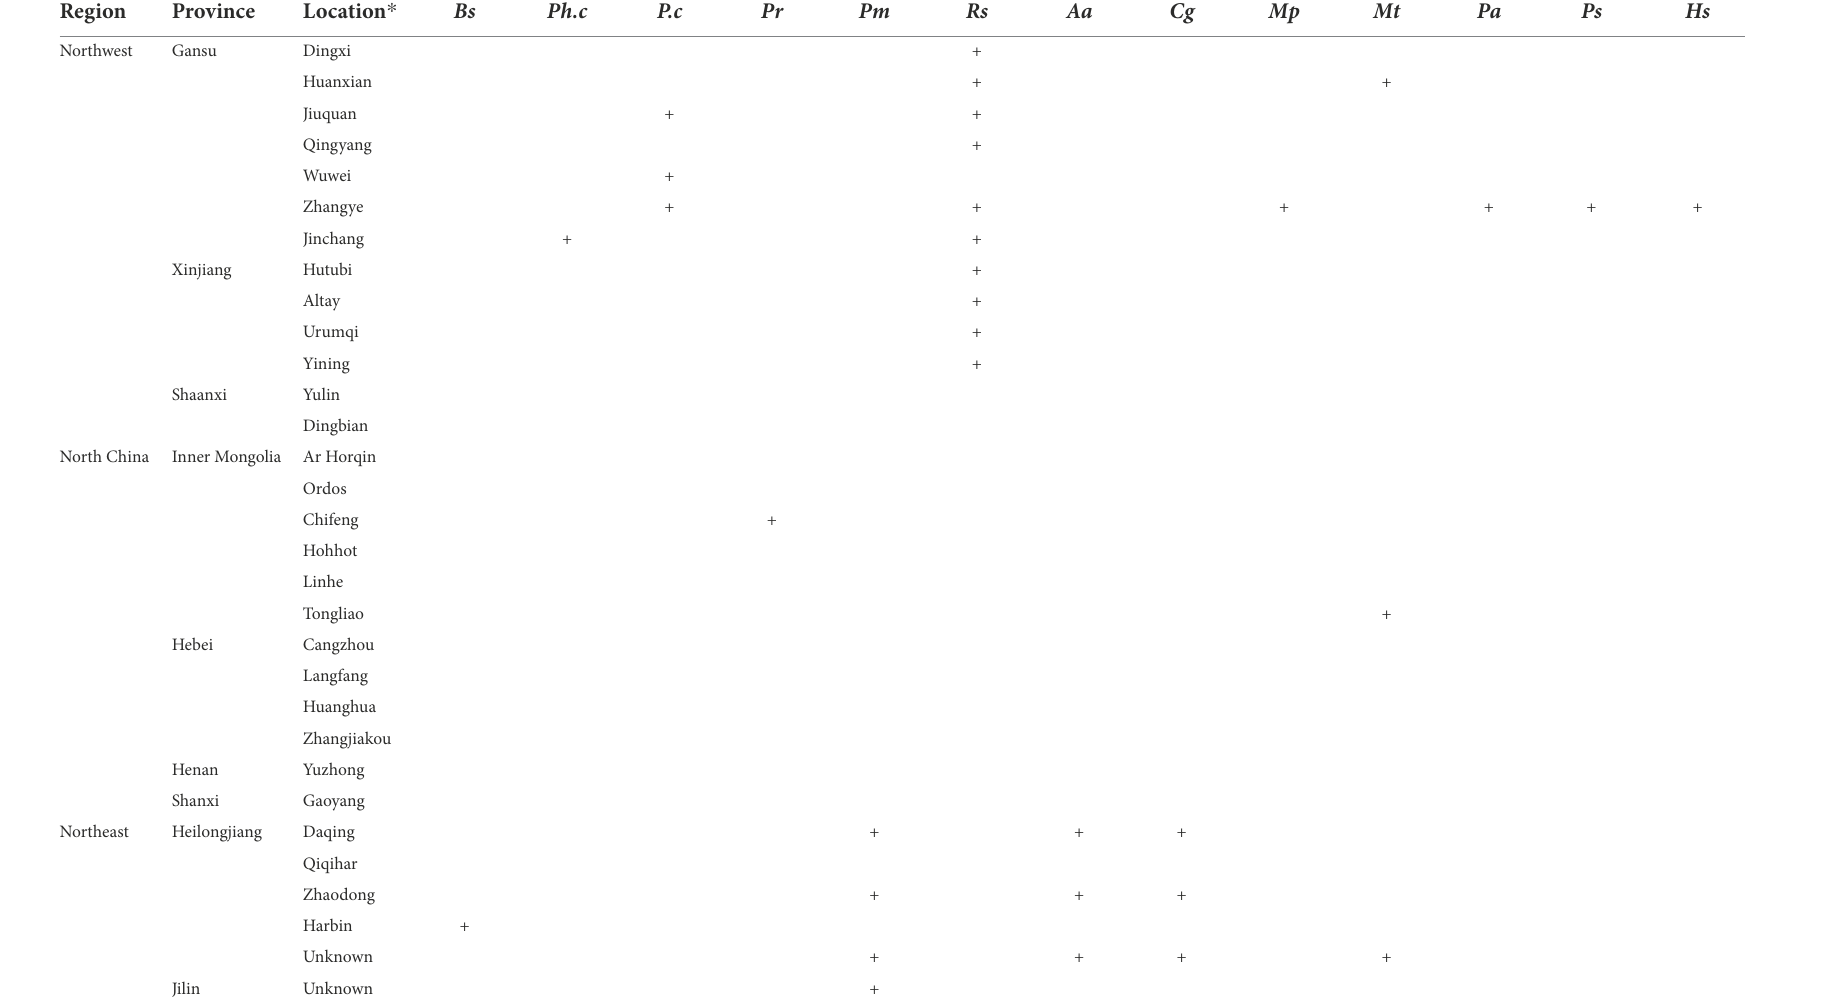
TABLE 2 Records of pathogens other than Fusarium spp. in the alfalfa-growing regions of China. Region Northwest